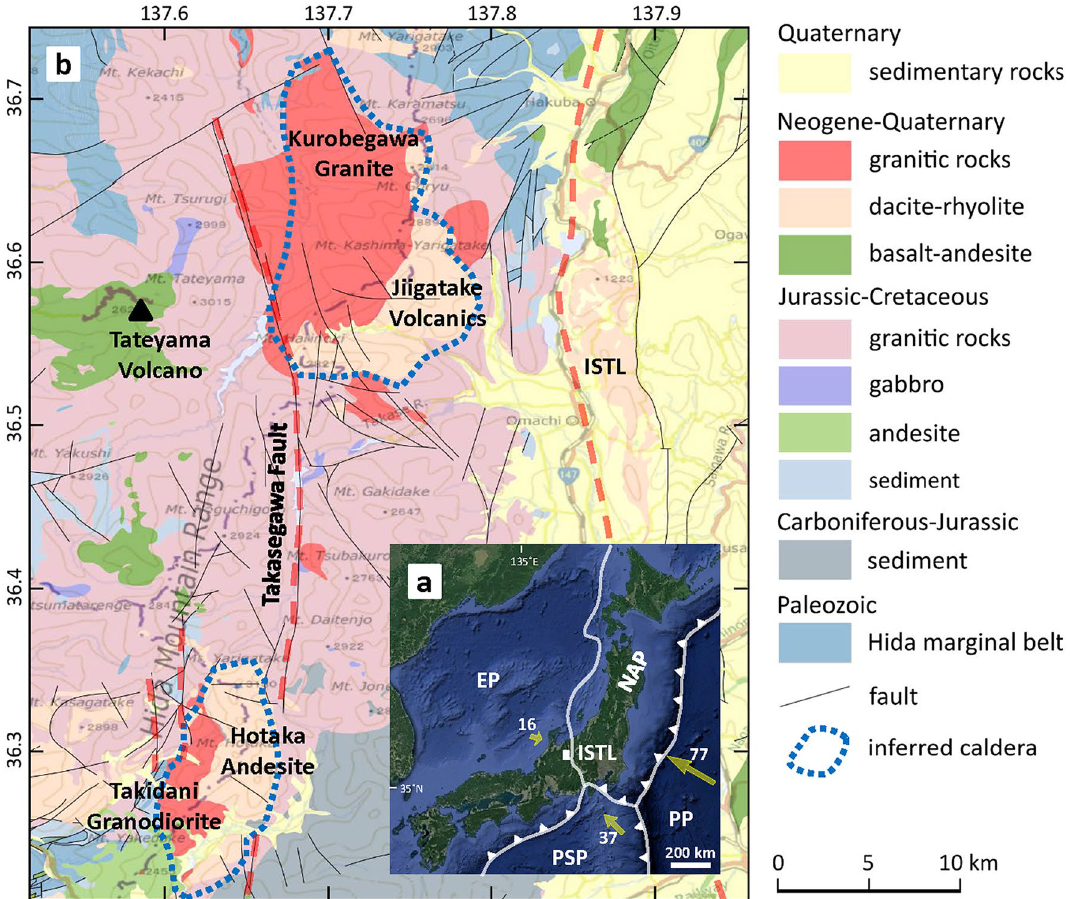
Figure 1. ( a ) Map of Japan with tectonic boundaries (white lines) and the location of the study site shown by a white rectangular. The base map is from Google Earth. ( b ) Geological map of the Hida Mountain Range showing the location of two Quaternary granitic plutons: the Kurobegawa Granite and the Takidani Granodiorite. The plutons lie between N–S tectonic lineaments (red dashed lines). ISTL Itoigawa–Shizuoka Tectonic Line, EP Eurasian Plate, NAP North American Plate, PSP Philippine Sea Plate, PP Pacific Plate. Yellow arrows in ( a ) indicate plate motion vectors (numbers indicating mm/year) relative to the North American Plate 12 . A black triangle in ( b ) is an active volcano (Tateyama Volcano). Geological map is modified from Seamless digital geological map of Japan 1: 200,000 (Geological Survey of Japan, AIST) using QGIS software (version 3.18.3) (https:// qgis. org/ ja/ site/) and Inkscape (version 1.0.2) (https:// inksc ape. org/). The base map in ( b ) is the Chiriin Tile (Japan and Its Surroundings) (http:// maps. gsi. go. jp) from the Geospatial Information Authority of